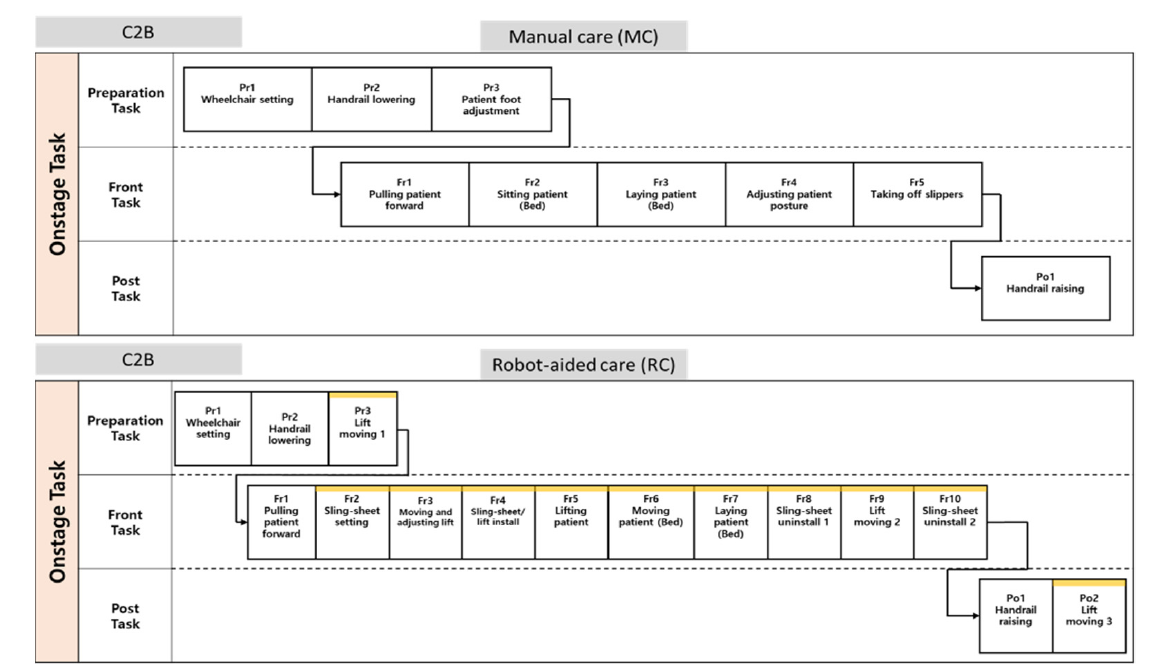
Figure 2. Structures of C2B sub-tasks for both MC and RC.